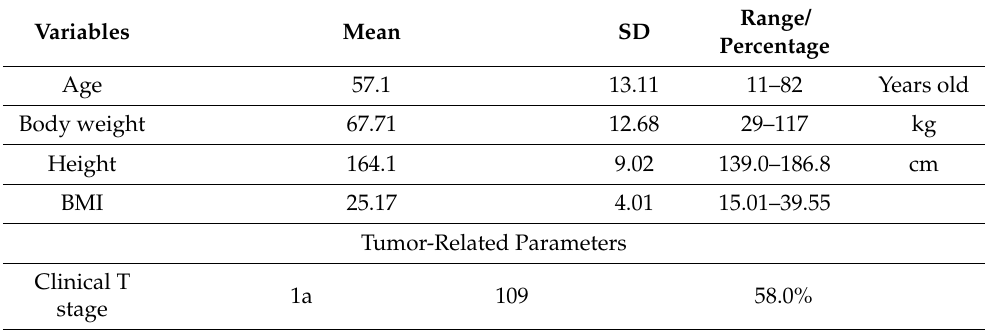
Table 1. Patients’ General Characteristics.